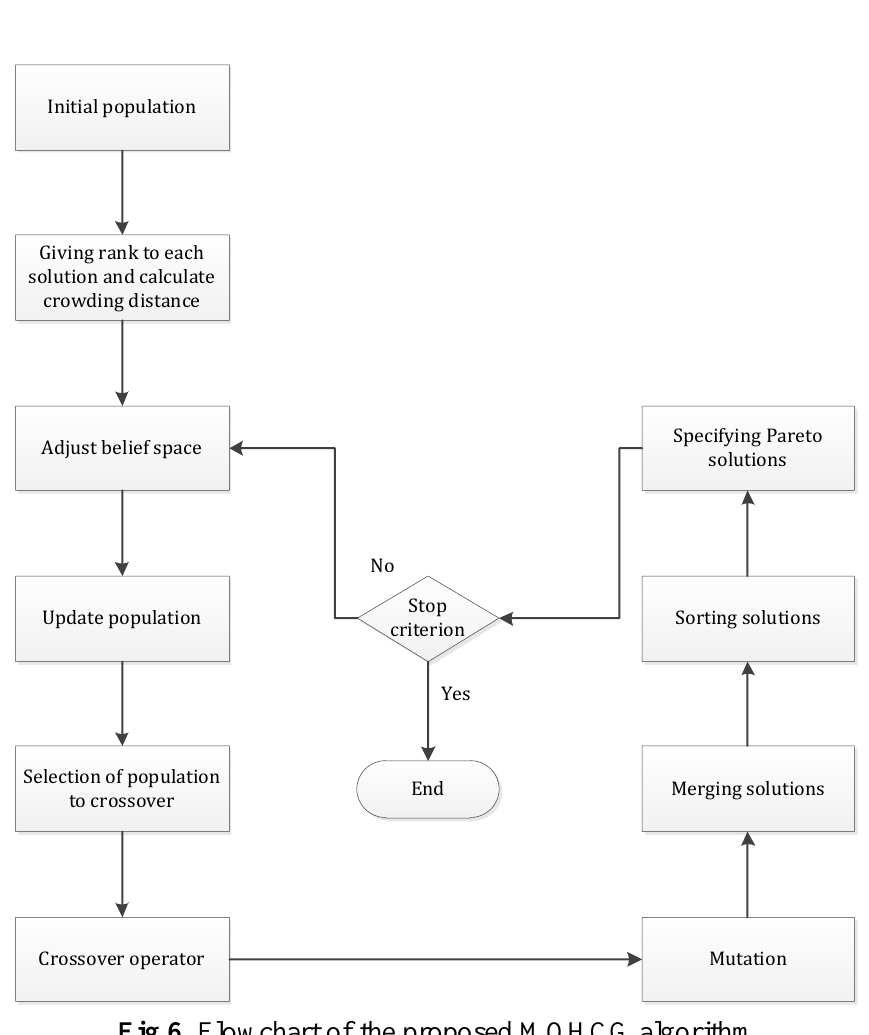
Fig 6 . Flowchart of the proposed MOHCG